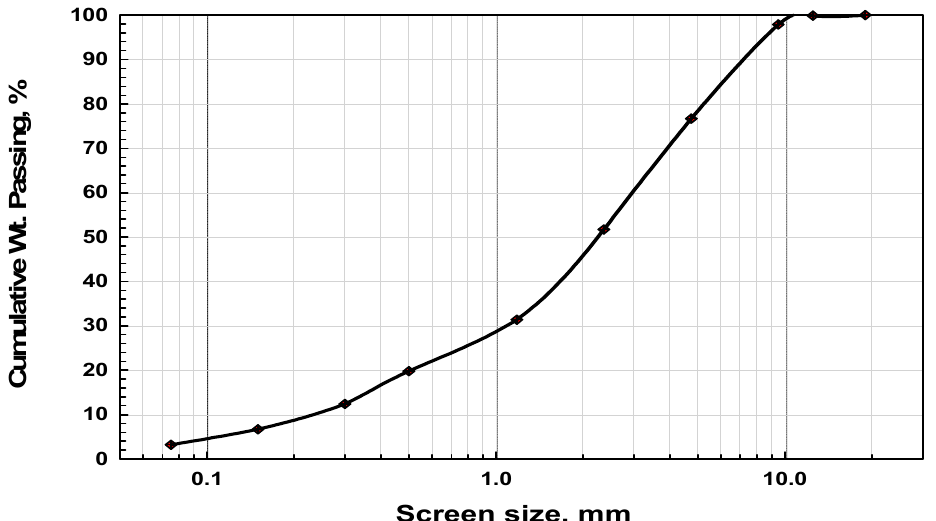
Figure 1. Particle size distribution of the as-received natural pozzolan.